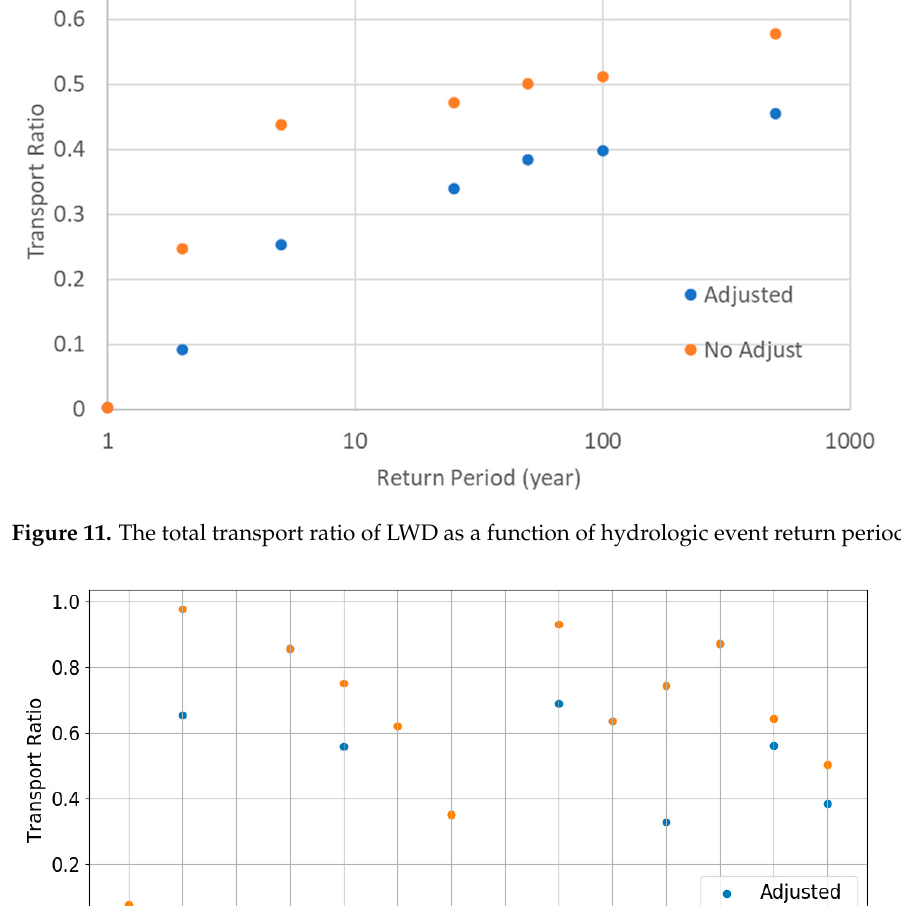
Figure 10. Potential deposition locations for LWD within the MF Feather River. ( a ) LWD deposited on meander bend and island. ( b ) LWD trapped above flow height and along banks entering a me- ander. ( c ) LWD trapped on islands and in areas where the channel expands at the lateral extent. ( d ) LWD trapped on rocks.